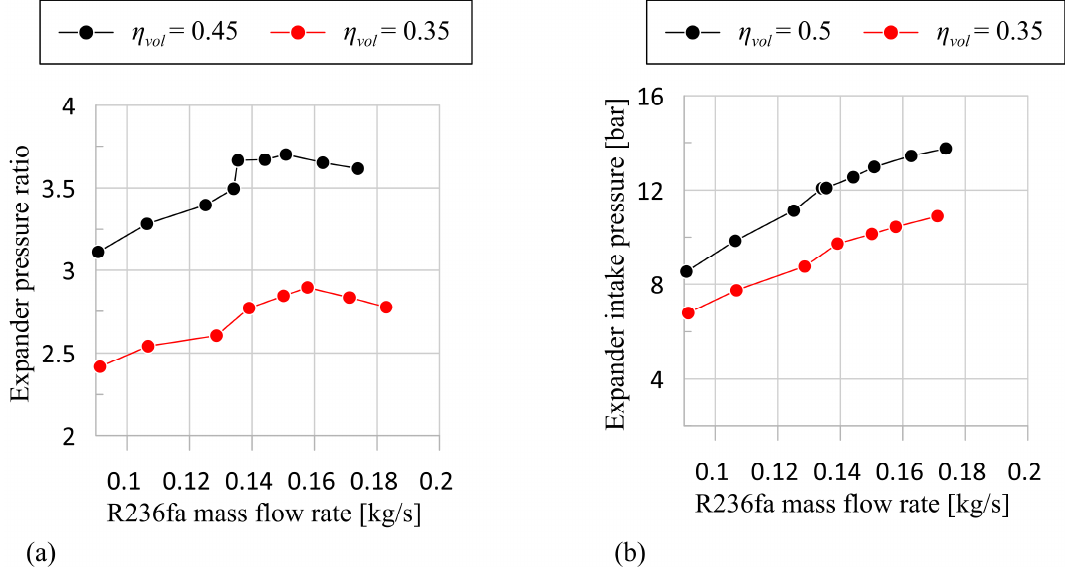
Figure 14. ( a ) Expander pressure ratio as function of volumetric efficiency; ( b ) Effect of volumetric efficiency on expander intake pressure.